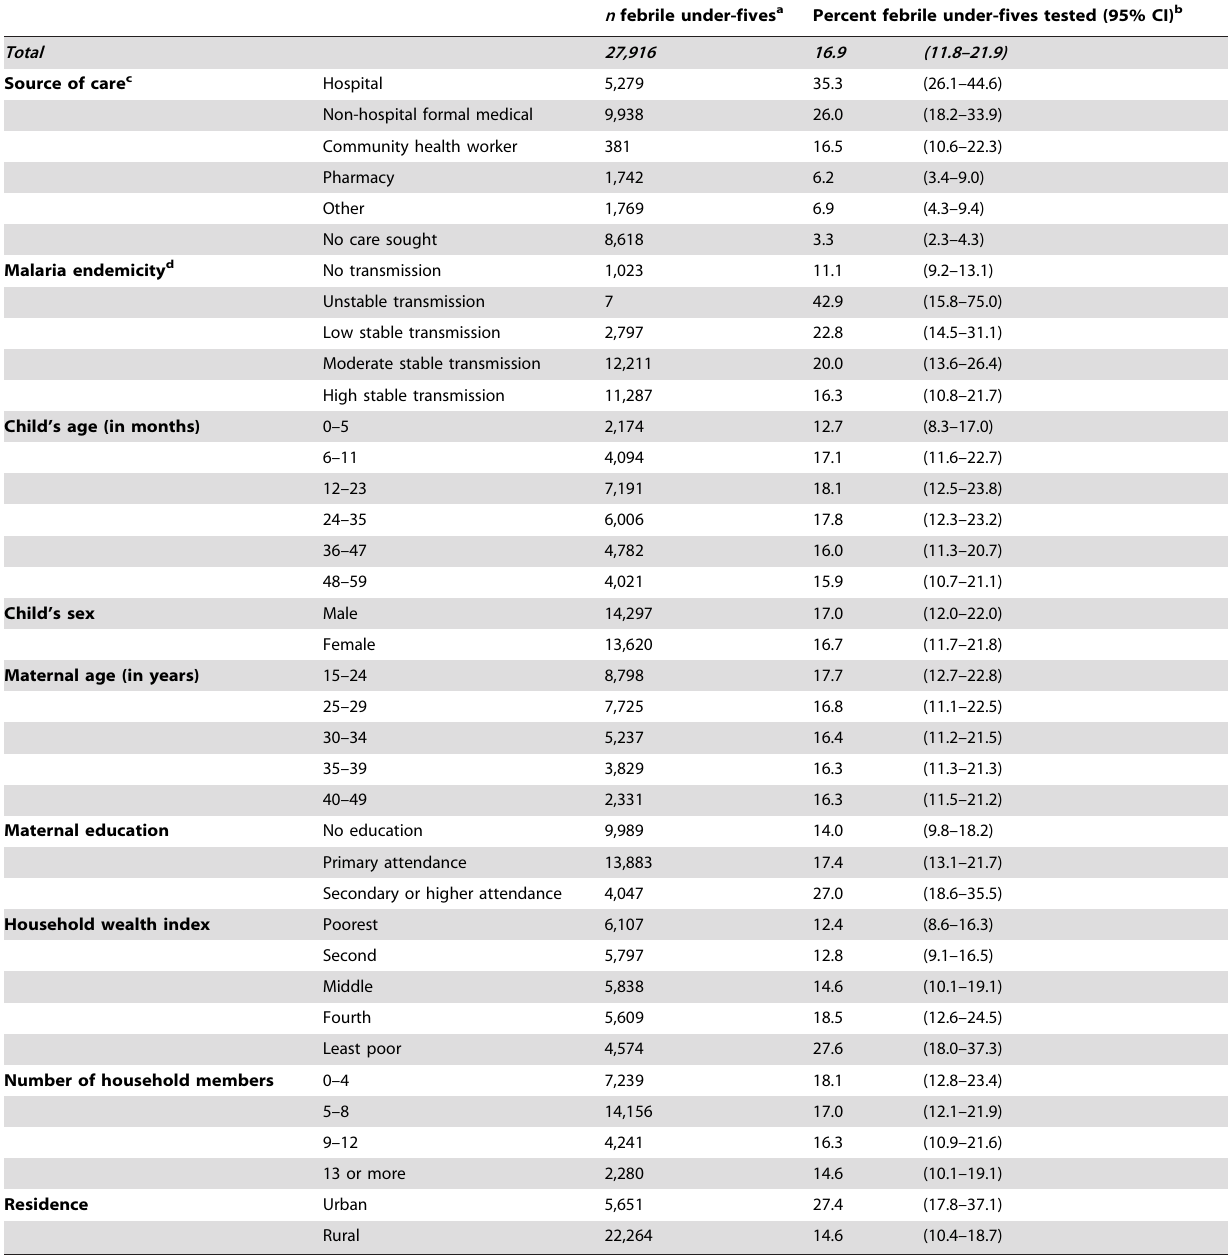
Table 2. Characteristics of febrile children less than five years old reportedly tested in 13